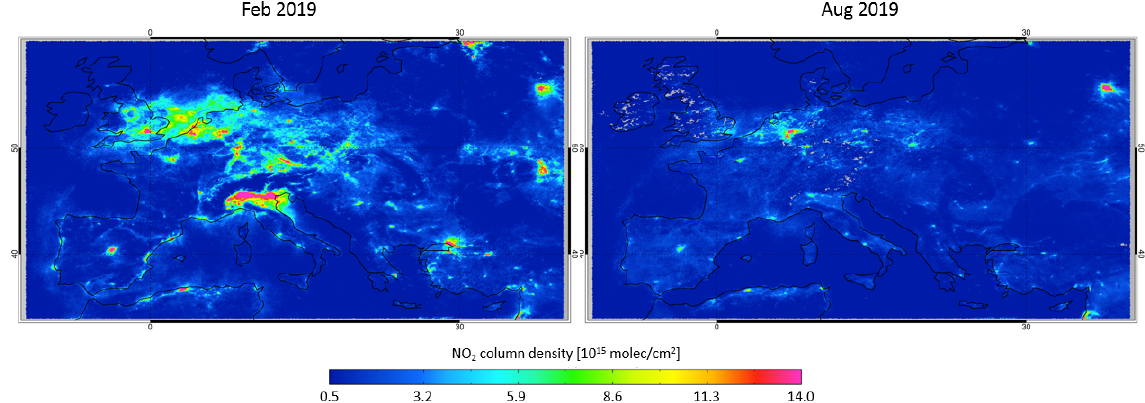
Figure 2. Tropospheric NO 2 columns from the reference algorithm over Europe in February and August 2019. Only measurements with a cloud radiance fraction less than 0.5 are included. Table 1. Overview of tropospheric NO 2 column retrievals. See Table 2 for details of the chemistry transport models used to obtain the a priori NO 2 profiles for the DLR improved retrieval in this